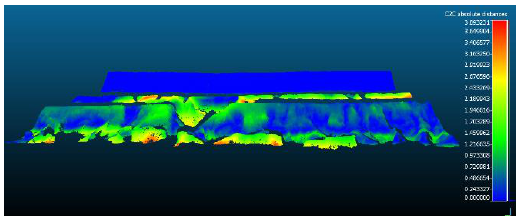
Figure 40. The example of result for cloud to cloud distances computation which was colored with those approximate